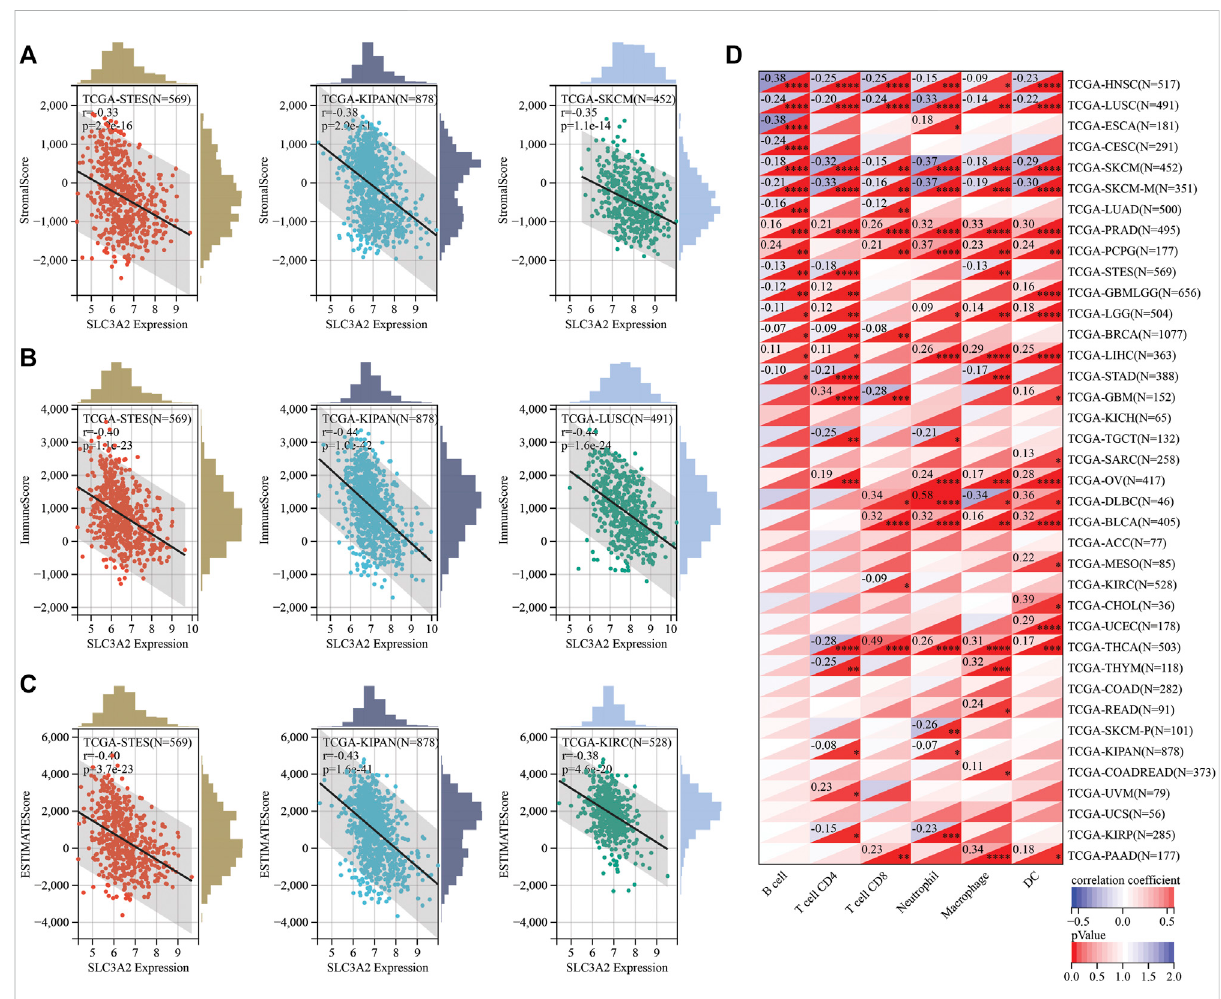
FIGURE 4 Correlation between SLC3A2 expression and constitution of microenvironment (A – C) SLC3A2 expression was negatively correlated with stromal score, immune score, and estimate score, respectively. Three cancer types with the largest correlation coef fi cient were visualized. (D) Correlation between SLC3A2 expression and six immune cells in fi ltration in